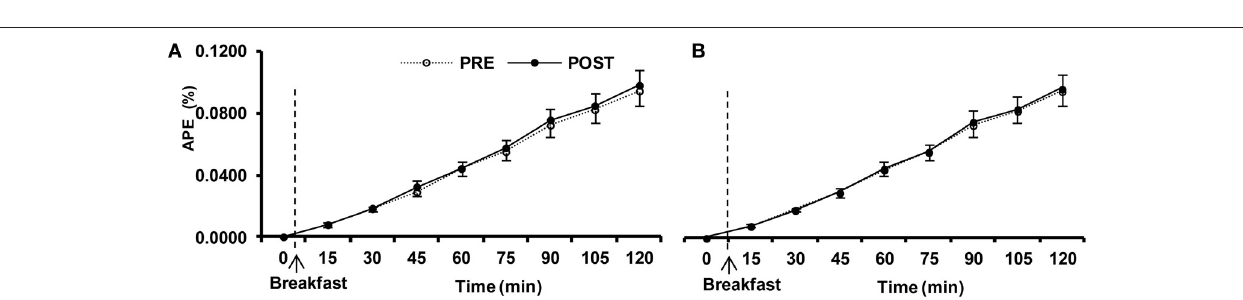
FIGURE 5 | Isotopic enrichement of expired CO 2 expressed in atom percent excess (APE) in postprandial response before (PRE) and after (POST) the 10-day normoxic (NORMOXIC; A) and hypoxic (HYPOXIC; B) confinements. Values are mean ± SEM. *Indicates significant ( p < 0.05 ) difference between PRE and POST